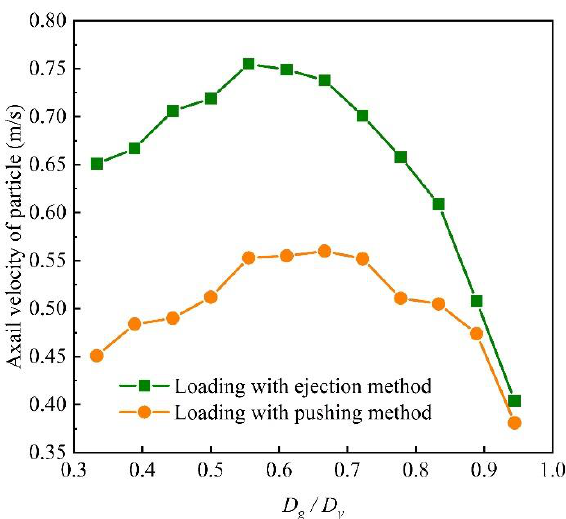
Figure 21. Comparison of particles’ axial velocities under ejection and pushing conditions ( D y = 900